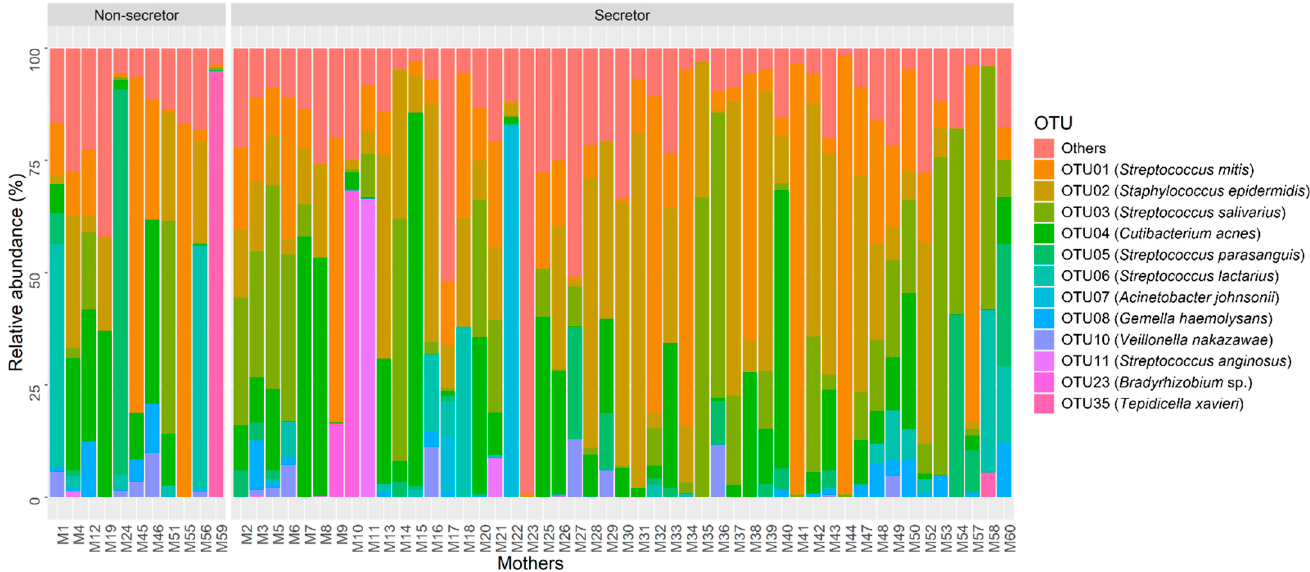
Figure 1. Relative abundance of the 12 most abundant OTUs in human milk samples based on maternal secretor status (non-secretor, n = 11; secretor, n = 49).